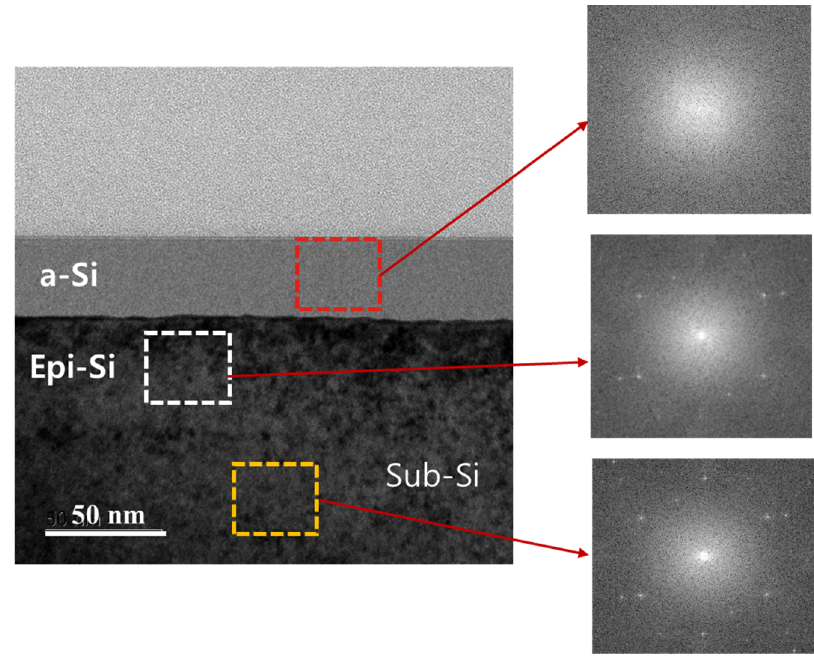
Figure 4. Diffraction patterns for a-Si, Sub-Si, and Epi-Si.